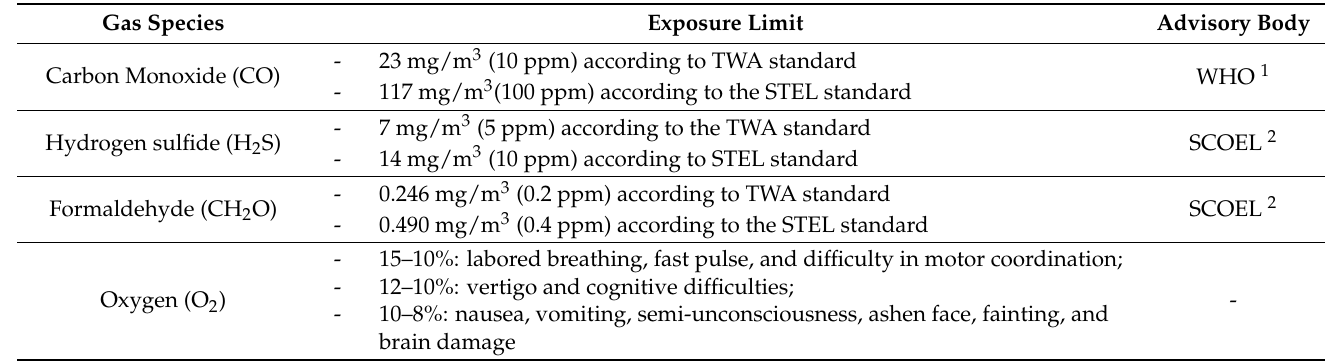
Table 1. Table summarizing the limit values of the detected gas